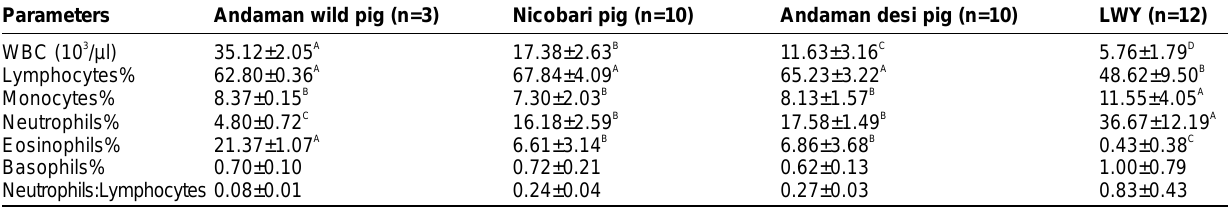
Table-2. Comparative leucocytic parameters of different pig breeds of Andaman and Nicobar Islands Parameters